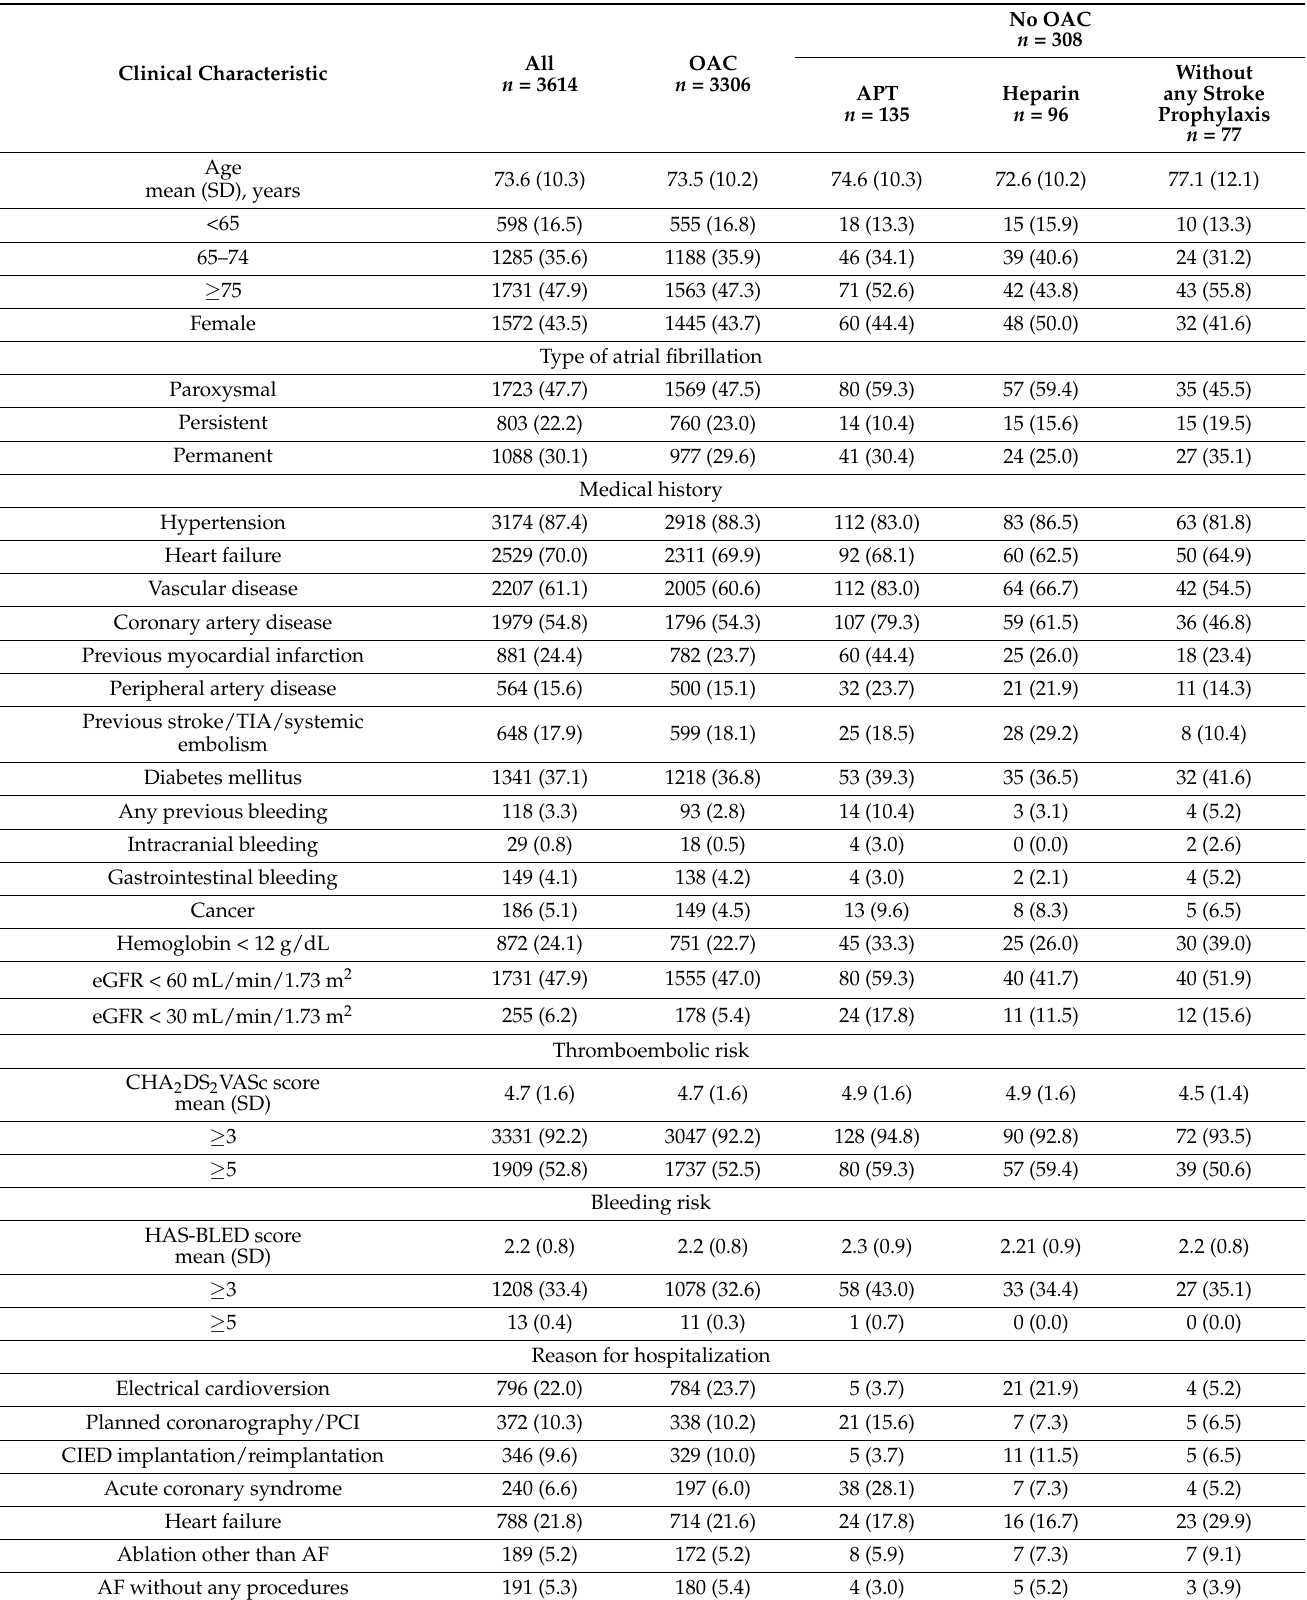
Table 1. Baseline characteristics of the study group according to antithrombotic